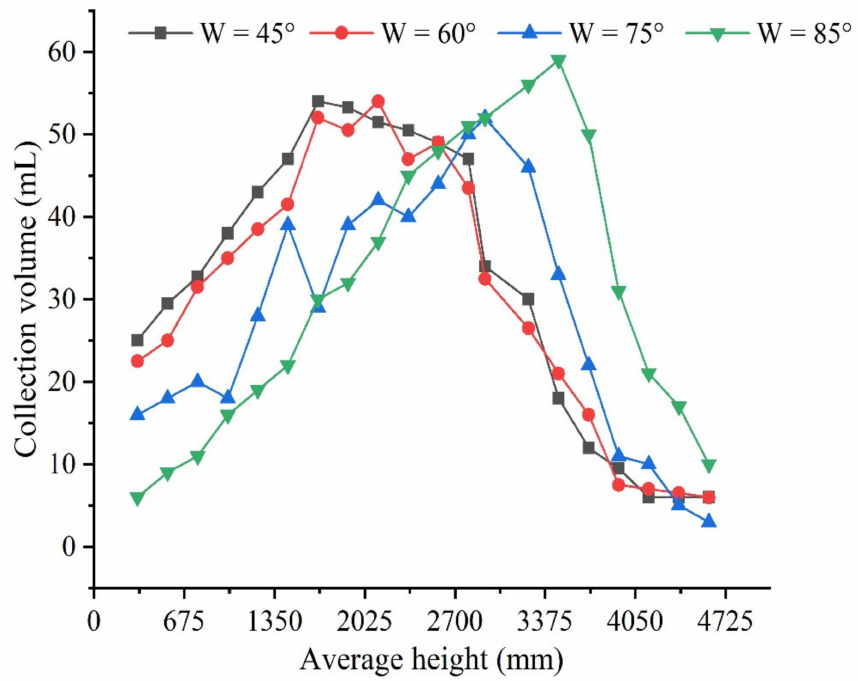
Figure 3. Influence of spray angle on the collection volume (N = 2400 r/min, L = 1.5